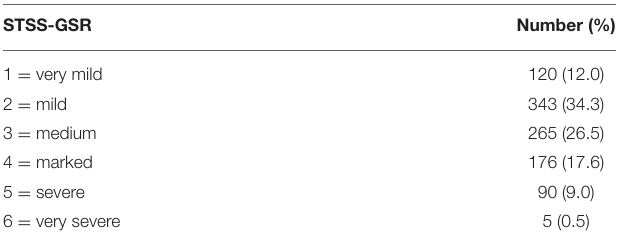
STSS-GSR, Global Severity Rating of the Shapiro Tourette-Syndrome Severity Scale.